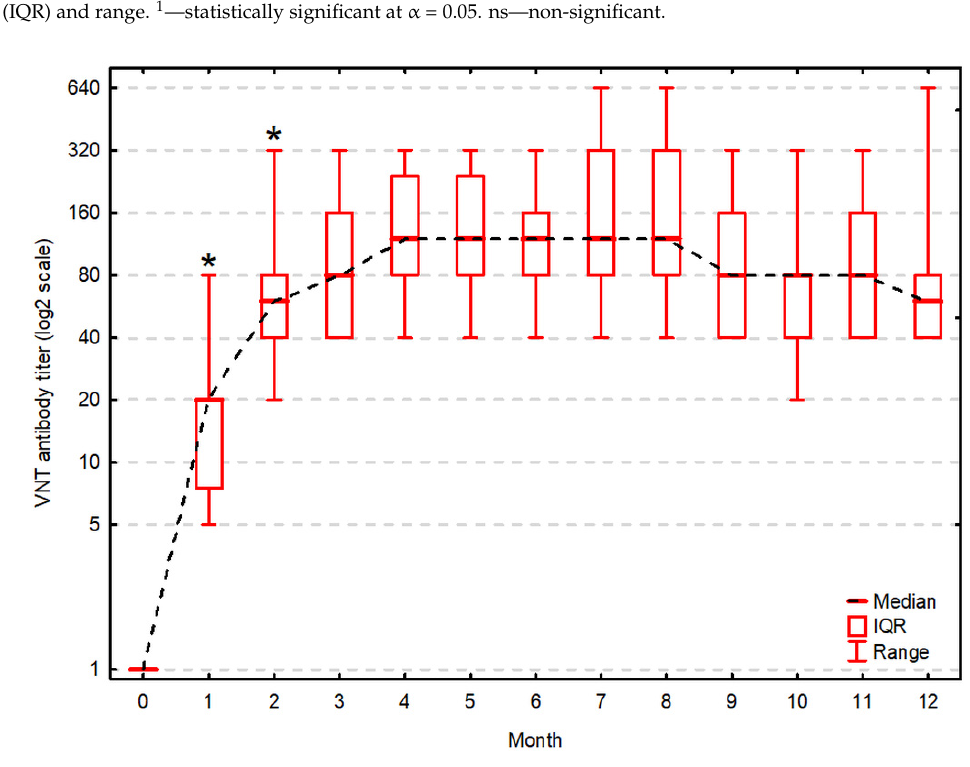
Figure 1. Antibody titers in virus neutralization test during 12 months post-vaccination. Antibody titers (on log base 2 transformed scale) are presented as the median, interquartile range (IQR) and range. Asterisk (*) indicates a statistically significant increase of the titer compared to the previous one ( α = 0.05).